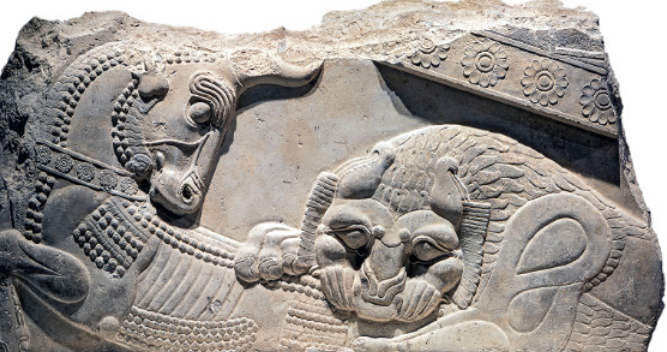
Figure 20. Lion attacking bull; relief panel; Apadana, Persepolis, Persia (mod. Iran); Achaemenid,